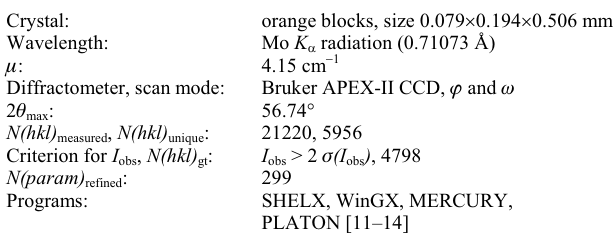
Table 1. Data collection and